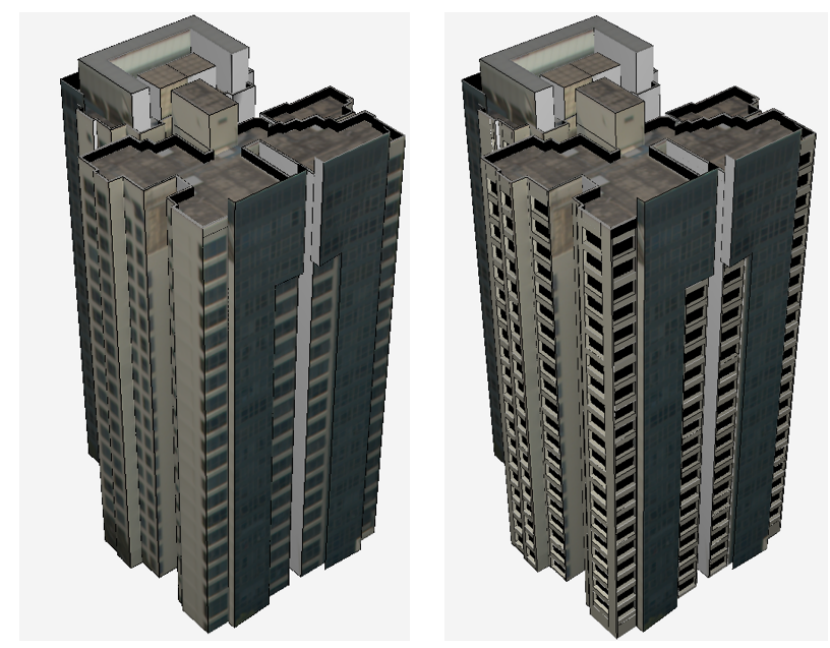
Figure 22. Façade template